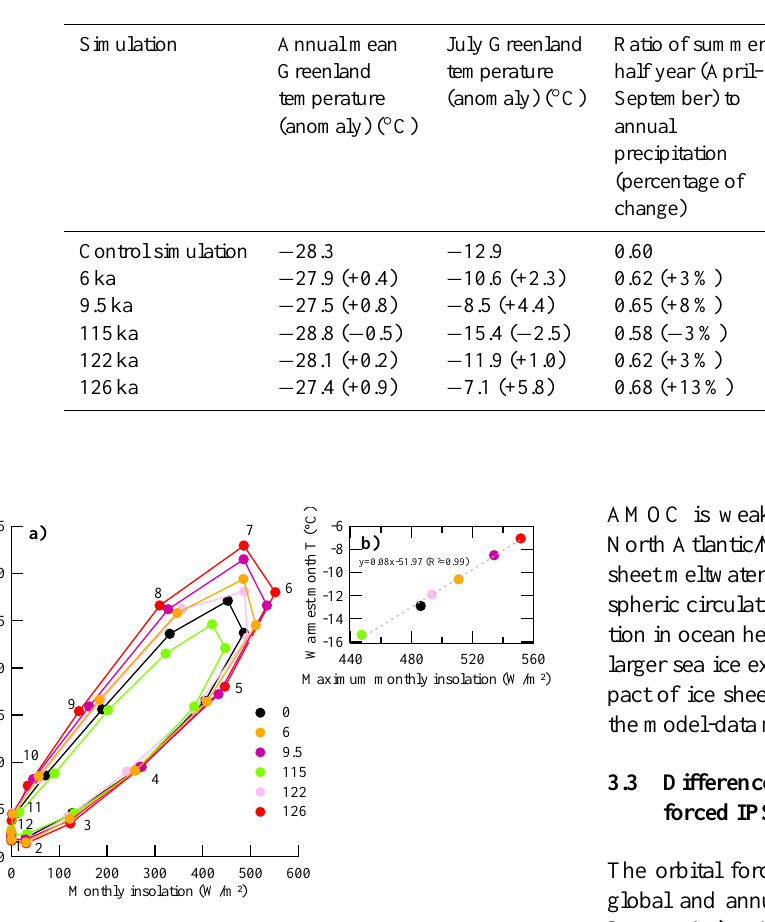
Table 2. IPSL-CM4 results for Greenland (from grid points located above 1300m elevation): annual mean, July and precipitation-weighted temperature ( ◦ C) as well as deposition effect (difference between precipitation-weighted and annual mean temperature) and ratio of summer (April–September) to annual precipitation. Results are given for the different simulations in response to orbital forcing only. Absolute values are given as well as anomalies with respect to the control simulation (numbers shown between parentheses).